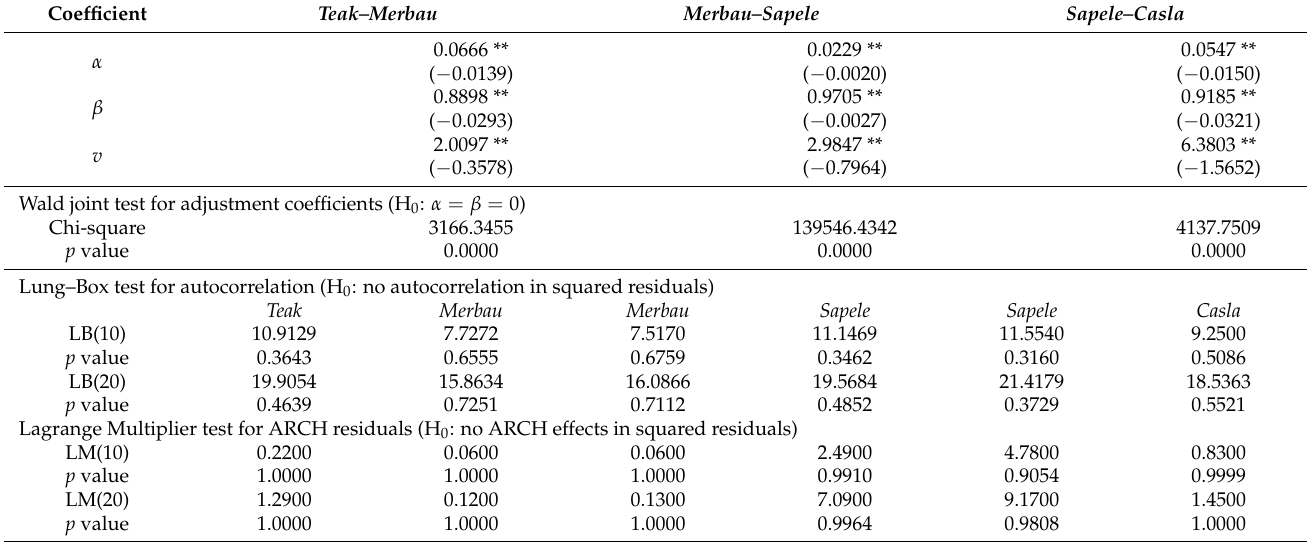
Table 5. The empirical results of the dynamic conditional correlation (DCC)